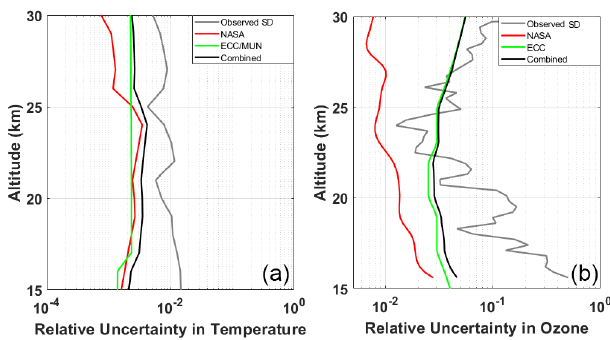
Figure 17. Comparison of relative uncertainties in both temperature and ozone for the RS41-SGP/RS92-SGP and ECC